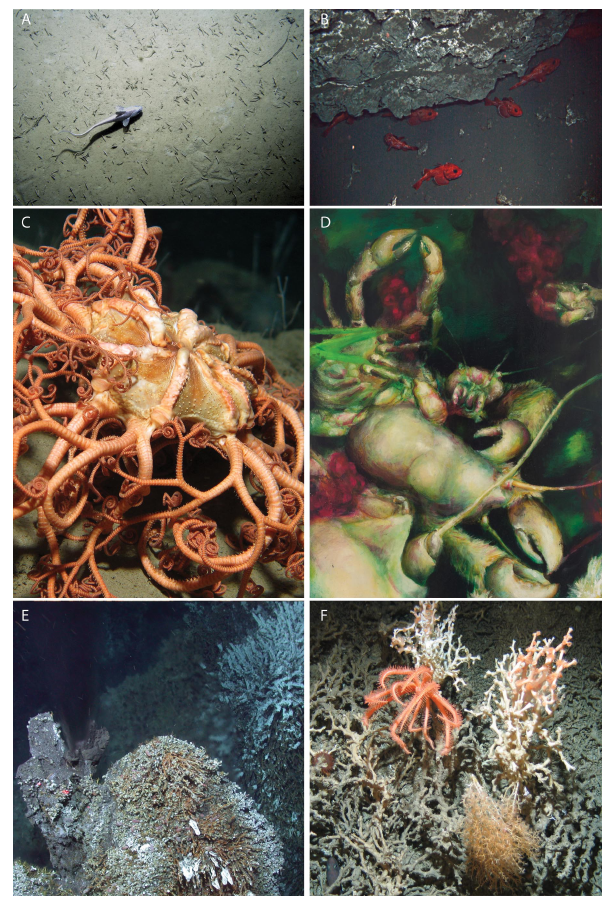
Figure 1. Examples of the species and habitats found in, and art work inspired by, the deep sea. (A) A field of the protists, Bathysiphon filiformis in Kaikoura Canyon, NZ (credit: D. Bow- den (NIWA)); (B) a large authigenic carbonate at Hydrate Ridge, CA, USA being used as a refuge by rockfish, Sebastes sp. (courtesy of L. Levin); (C) the basket star, Gorgonocephalus caputmedusae , was the first species ever sampled from the deep sea. (D) Art has been inspired by the strange fauna of the deep sea for many years. This is an example by Lily Simonson (http://oldgenres.com/), who uses deep-sea fauna as a muse for her paintings. (E) Hydrothermal vents provide areas of intense secondary production and potential resources for mining (courtesy of B. Grupe/R. Lee). (F) Ecosystem engineers, such as these deep-sea corals, provide both jewelry as well as areas of increased secondary production and demineraliza- tion (credit: Department BIS,